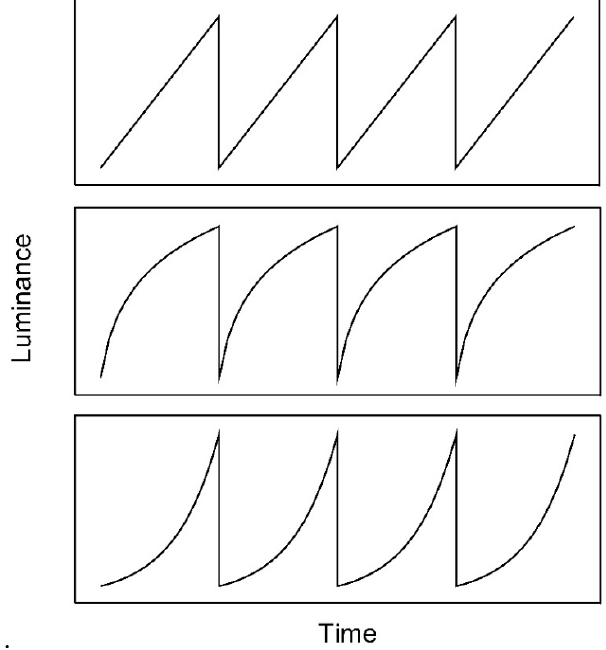
Figure 1. Linear ( upper panel ), logarithmic ( middle panel ), and exponential ( lower panel ) luminance ramps. Linear and exponential luminance ramps were used by Anstis [1] and Arnold and Anstis [4], respectively.